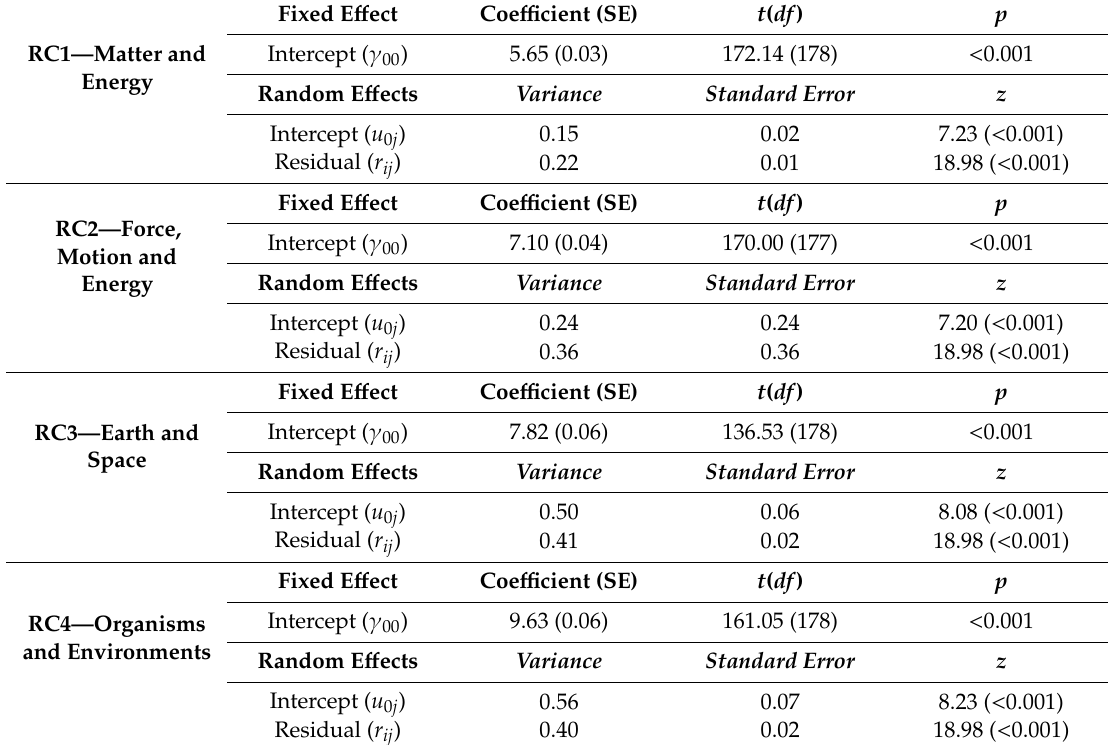
Table 3. Parameter estimates of fixed and random e ff ects of Model 1 by reporting